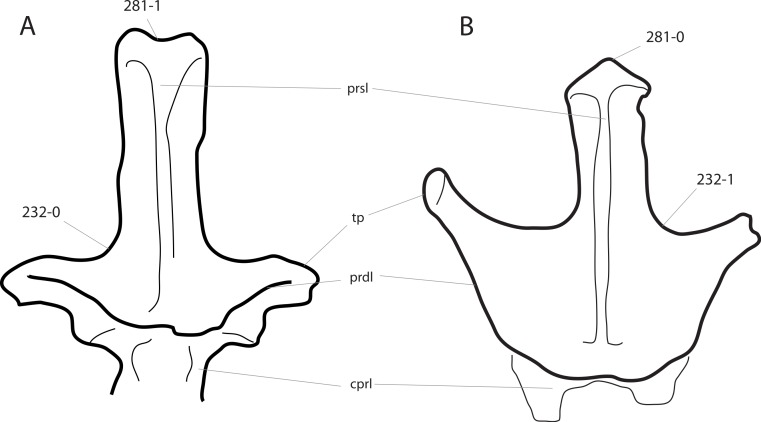
Diplodocimorph dorsal neural arches.Dorsal neural arches of Diplodocus carnegii CM 84 (A; traced from Hatcher, 1901) and Nopcsaspondylus alarconensis holotype specimen (B; traced from Nopcsa, 1902) in anterior view. Note the festooned spdl typical for rebbachisaurids (B; C232-1), in contrast to the plesiomorphic state (A; C232-0), and the notched (A; C281-1), or straight to convex spine summits (B; C281-0). Abb.: cprl, centroprezygapophyseal lamina; prdl, prezygodiapophyseal lamina; prsl, prespinal lamina; tp, transverse process. Not to scale.